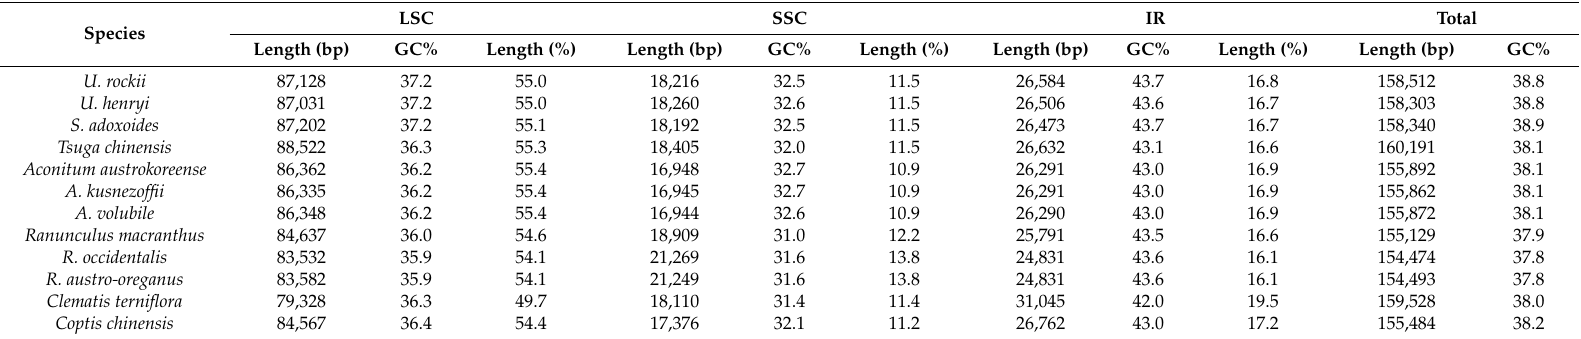
Table 1. Summary of complete chloroplast genomes. LSC, large single-copy; SSC, small single-copy; IR, inverted repeat